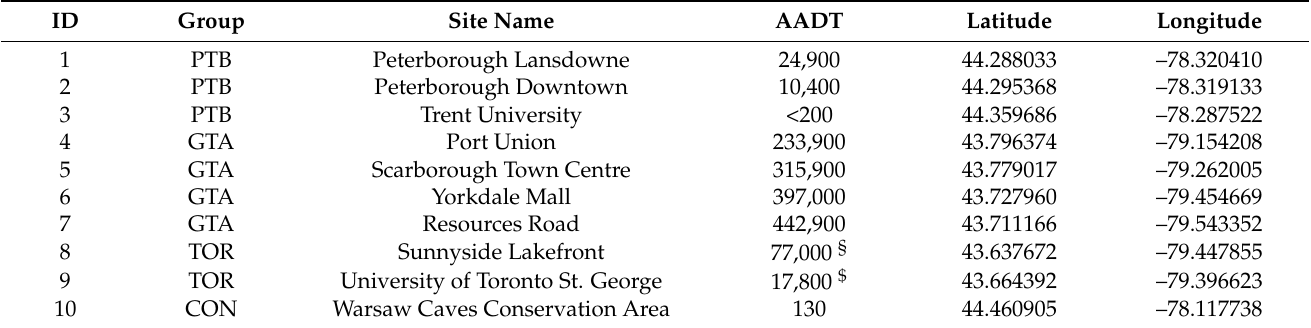
Figure 1. Location of the ten study sites; nine sites where moss bags were deployed from 9 October to 23 November 2020 (45 days) and the rural background site at Warsaw Caves Conservation Area where Pleurozium schreberi (Brid.) Mitt. (red-stemmed feather moss) was obtained for the moss bags (see Table 1). The inset shows the location of the study area in north America. Table 1. Site ID; group (urban intensity); name; annual average daily traffic (AADT, vehicles day −1 ); and coordinates (latitude and longitude, decimal degrees) for the nine deployment sites and the rural background site in southern Ontario, Canada ( n = 10).